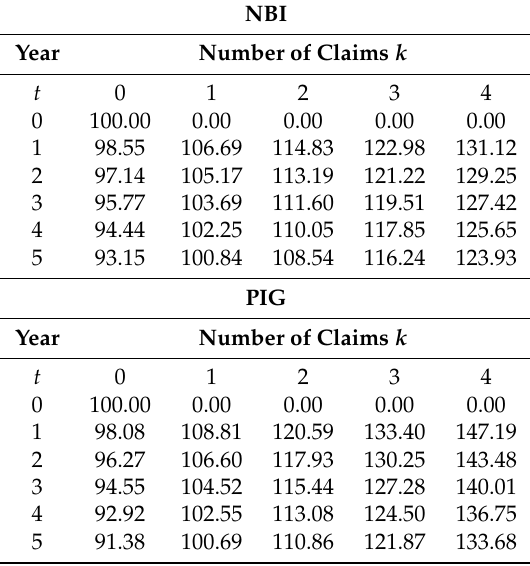
A Posteriori, or Bonus-Malus, premiums for risk class 1, regression models with varying